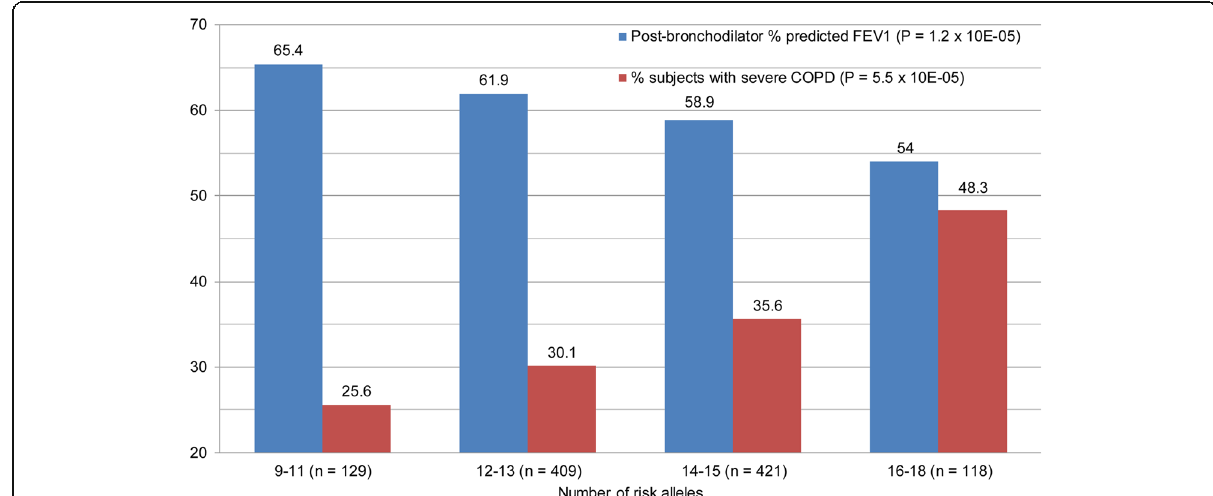
Fig. 3 Joint analysis of 10 candidate SNPs in 1077 SPIROMICS non-Hispanic White smokers with COPD. 10 SNPs include rs28929474 in SERPINA1 , rs1980057 in HHIP , rs2869967 in FAM13A1 , rs2070600 in AGER , rs1435867 in PID1 , rs12477314 in HDAC4 , rs1529672 in RARB , rs12914385 in CHRNA3 ,